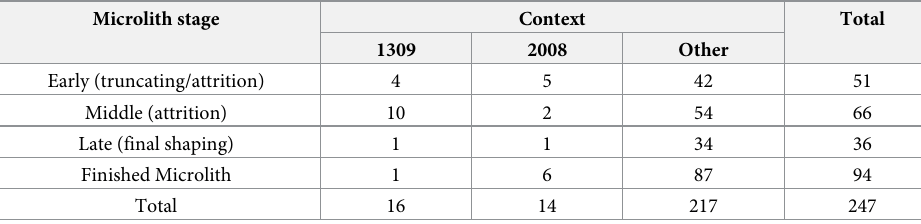
Table 5. Microlith stages, Horizon IV, Saruq al-Hadid.